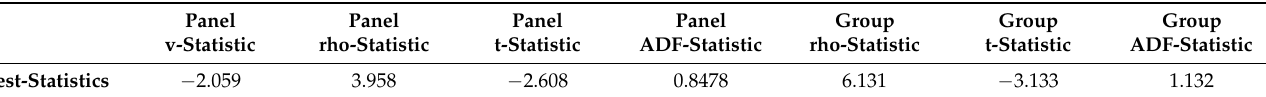
Table 9. Pedroni Panel Cointegration